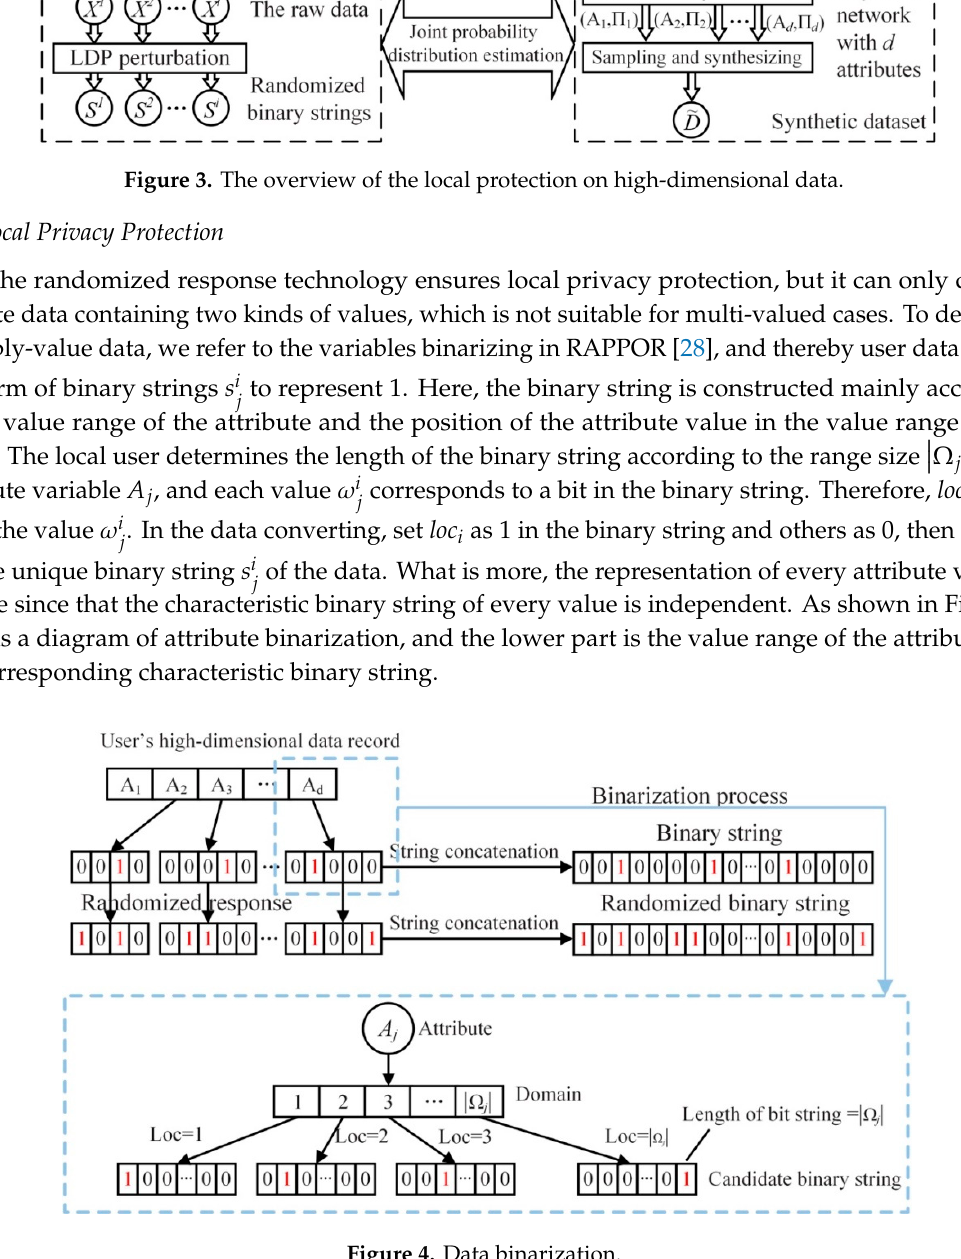
Figure 4. Data Figure 4. Data binarization. Figure 4. Data binarization.